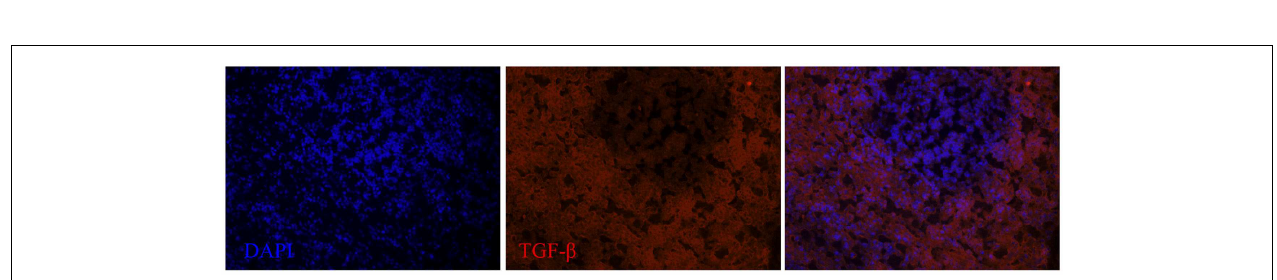
FIGURE 5 | IL-6 and IL-8 expression in the spleen of a dolphin with hyperinsulinemia . Dolphin splenic tissue sections were incubated with primary anti-porcine IL-6 or anti-dolphin IL-8, followed by anti-dolphin CD2, and nuclear staining usingVECTASHIELD mounting medium with DAPI. Original magnification 20 × .